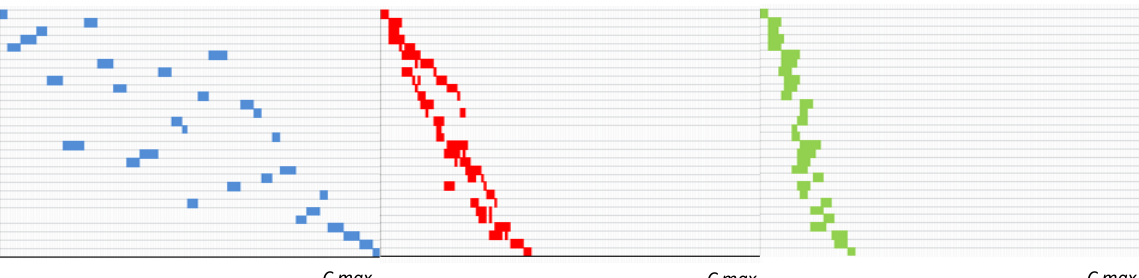
Fig. 12. Results of Serial programming, BFSM-GA (Active RCPSP) and BFSM-GA (Relaxed RCPSP) for Example 11 with 30 variables (Left to